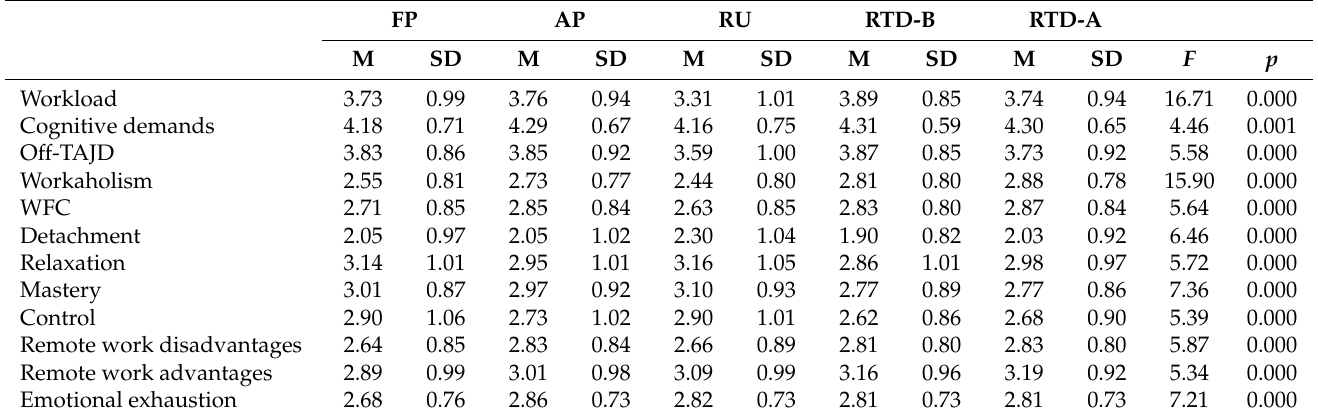
Table 5. Means, standard deviations, and ANOVA for the academics sample by